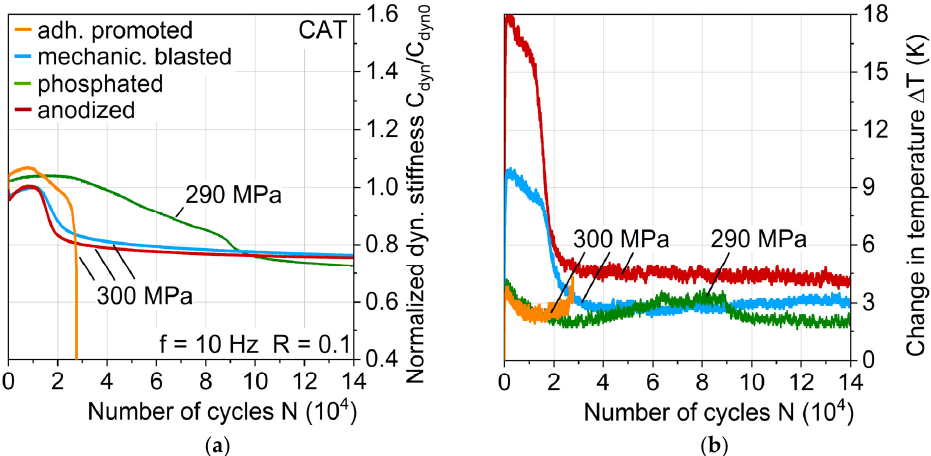
Figure 13. Influence of aluminum surface treatment on ( a ) normalized dynamic stiffness and ( b ) change in temperature (plotted linearly) during constant amplitude tests.